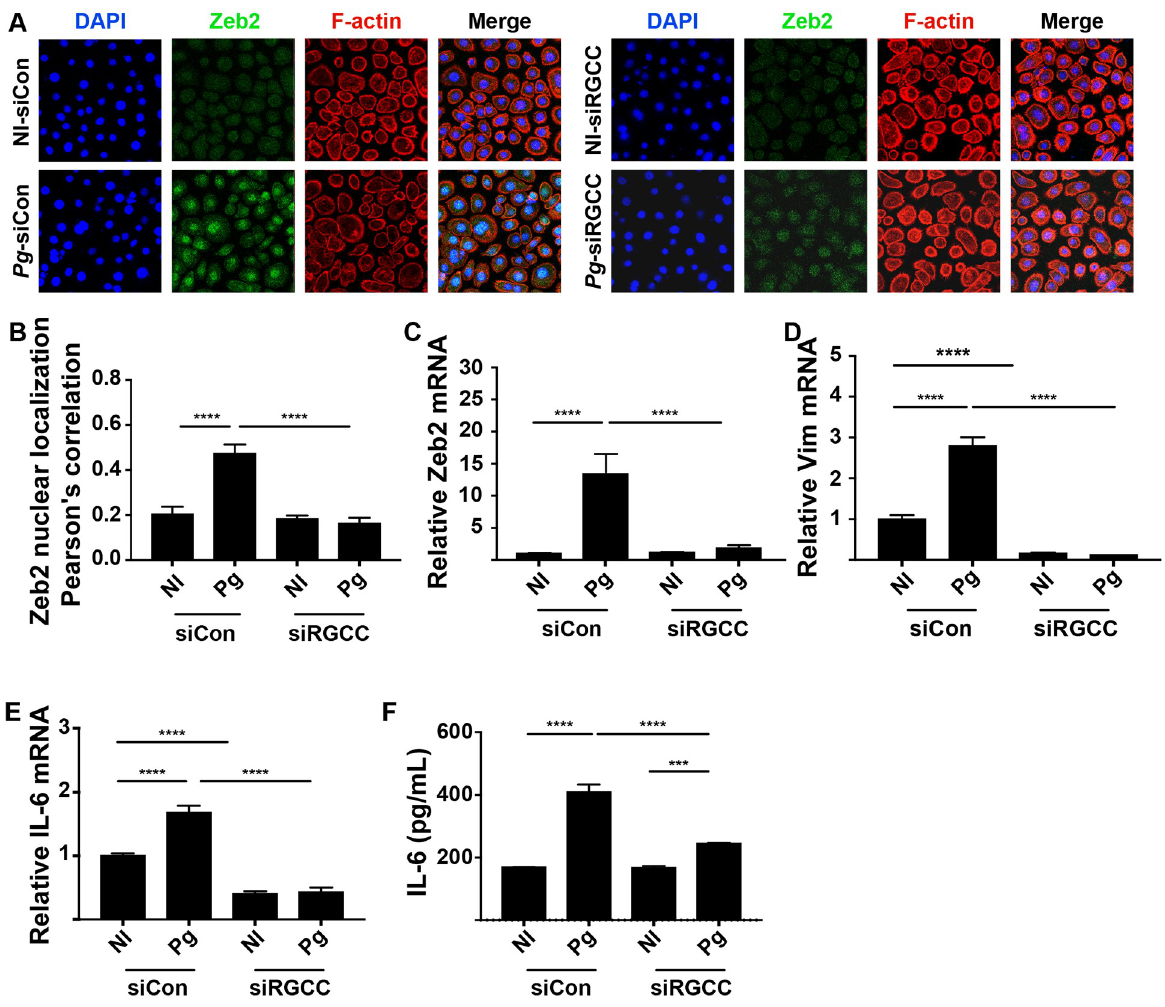
Fig 8. P . gingivalis -induced RGCC regulates Zeb2, IL-6 and in vivo pathogenicity. A) Fluorescent confocal microscopy of TIGK cells transiently transfected with siRNA to RGCC (siRGCC) or scrambled siRNA (siCon), and challenged with P . gingivalis (Pg) or left uninfected (NI). Cells were probed with Zeb2 antibodies as indicated, and Alexa Fluor 488 secondary antibody (green). Actin (red) was stained with Texas Red-phalloidin, and nuclei (blue) stained with DAPI. Cells were imaged at magnification × 63, and shown are projections of z-stacks generated with Volocity. B) Colocalization of Zeb2 with the nuclear region from the images in (A) using Pearson’s correlation in Volocity. C-E) TIGK cells were transiently transfected with siRNA to RGCC (siRGCC) or scrambled siRNA (siCon) and challenged with P . gingivalis (Pg). Expression of mRNA for Zeb2 (C), vimentin (D), or IL-6 (E) was measured by qRT-PCR. Data are expressed relative to noninfected (NI) controls. F) ELISA of IL-6 protein in TIGK supernatants. ��� p < 0.005, ���� p <